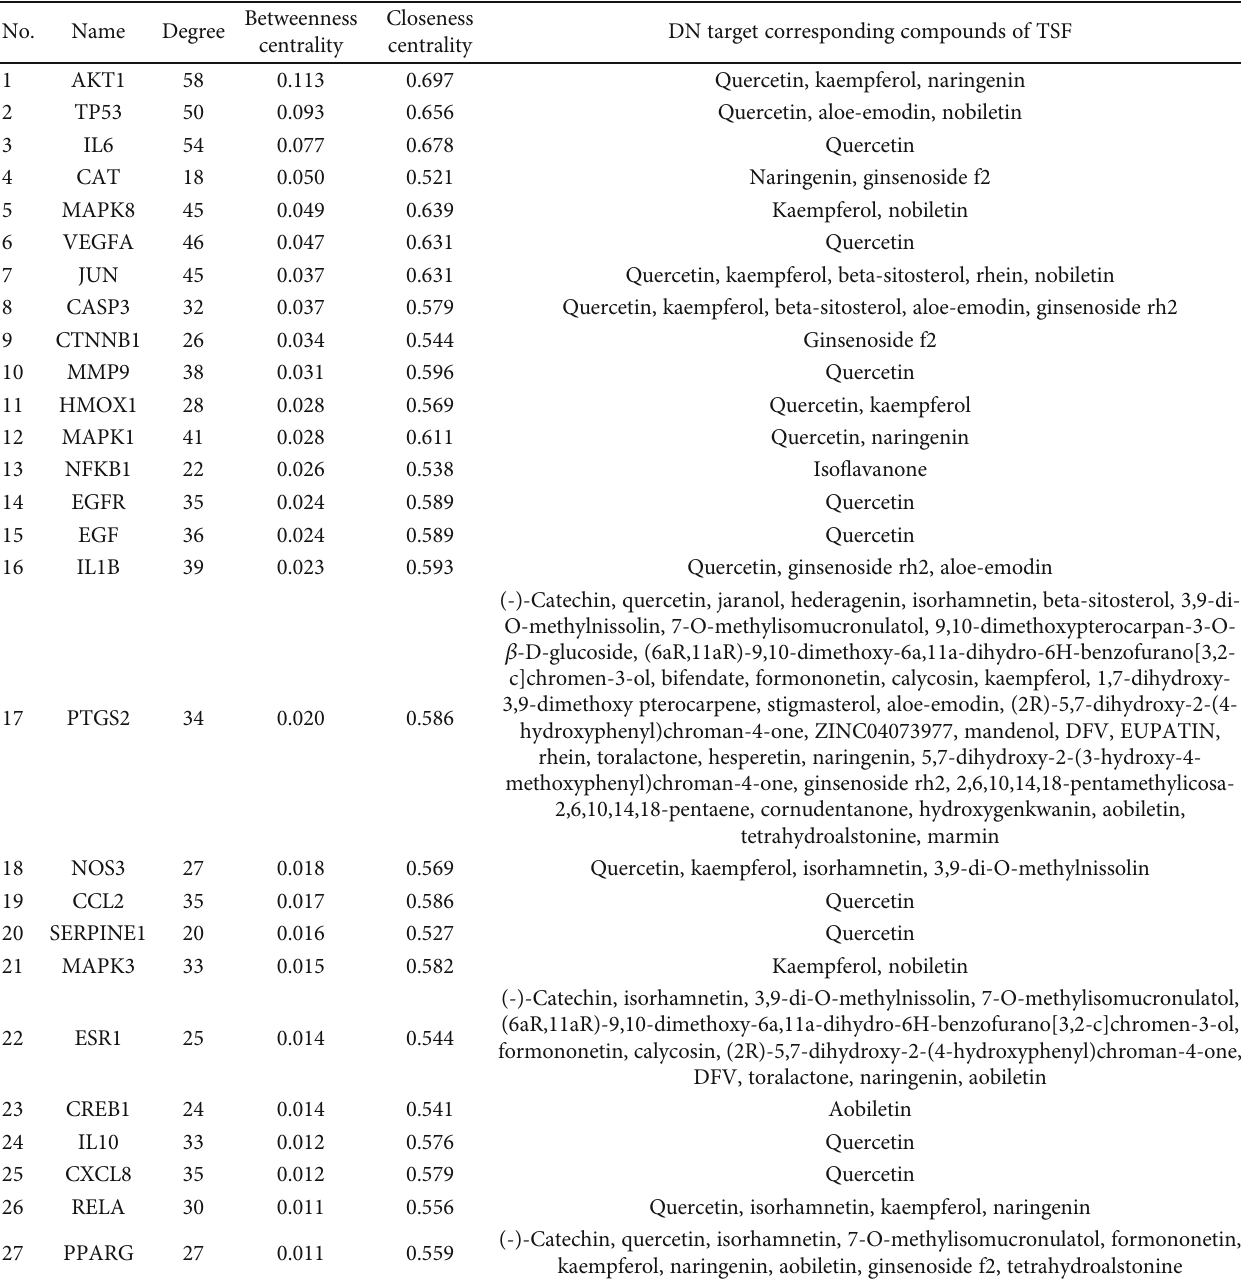
Table 2: The network topology parameters and active compounds were collected for 27 key TSF-DN cotargets from protein-protein international network.